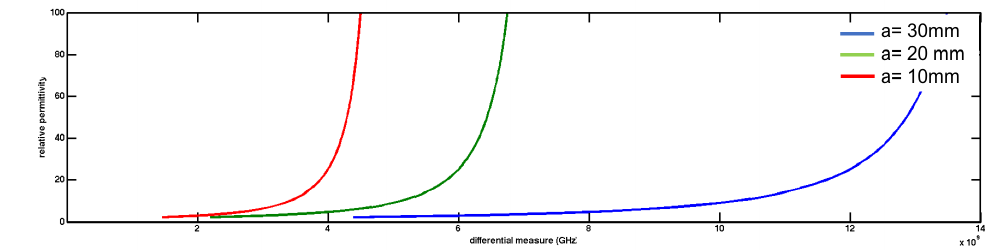
Figure 6. Permittivity obtained using differential measures in equation.